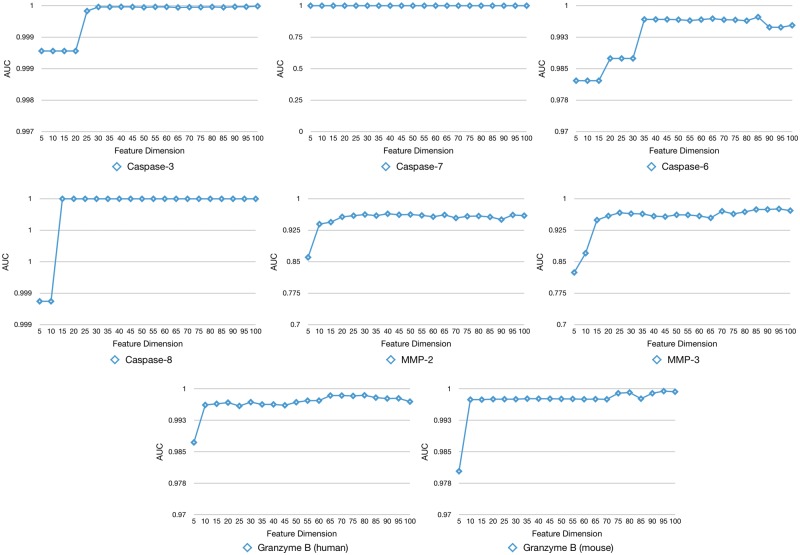
The feature selection curve in stepwise feature selection describes the performance change (in terms of AUC) as a function of the number of gradually increased OFCs.